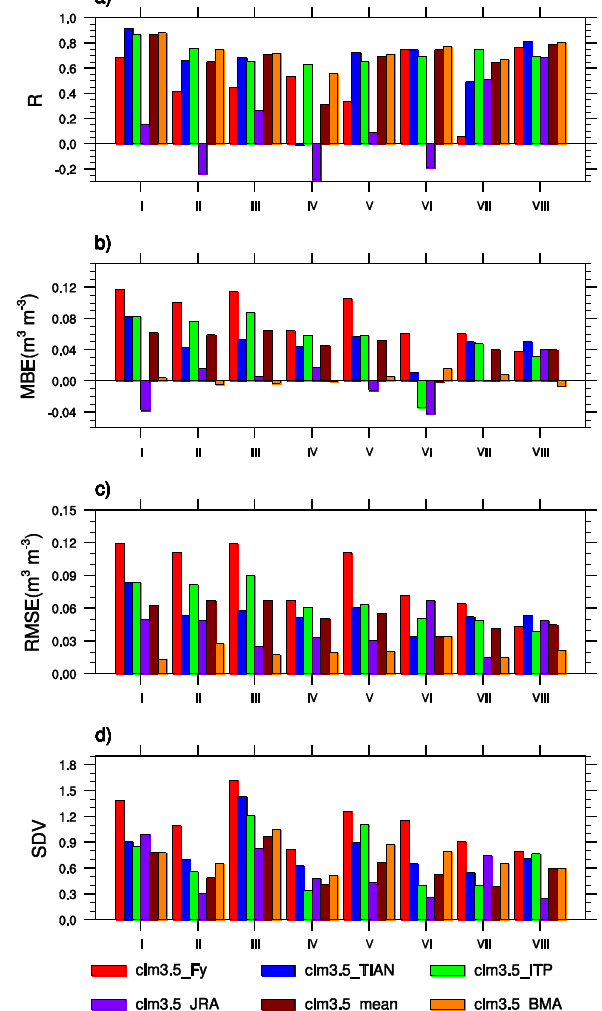
Fig.8. Statistical scores for CLM3.5_FY, CLM3.5_TIAN, CLM3.5_ITP, CLM3.5_ 719 Fig. 8. Statistical scores for CLM3.5 FY, CLM3.5 TIAN, CLM3.5 ITP, CLM3.5 JRA, CLM3.5 mean and CLM3.5 BMA in JRA, CLM3.5_mean and CLM3.5_BMA in the validation period July 2008 – June 720 the validation period July 2008–June 2010 in the 0–10cm soil layer in the eight subregions of China defined in Table 1: (a) correlation 2010 in the 0–10 cm soil layer in the eight subregions of China defined in Table 1: (a) 721 coefficient ( R ); (b) mean bias error (MBE); (c) root mean square error (RMSE); (d) normalized standard deviation correlation coefficient (R); (b) mean bias error (MBE); (c) root mean square error 722 (RMSE); (d) normalized standard deviation (SDV). 723